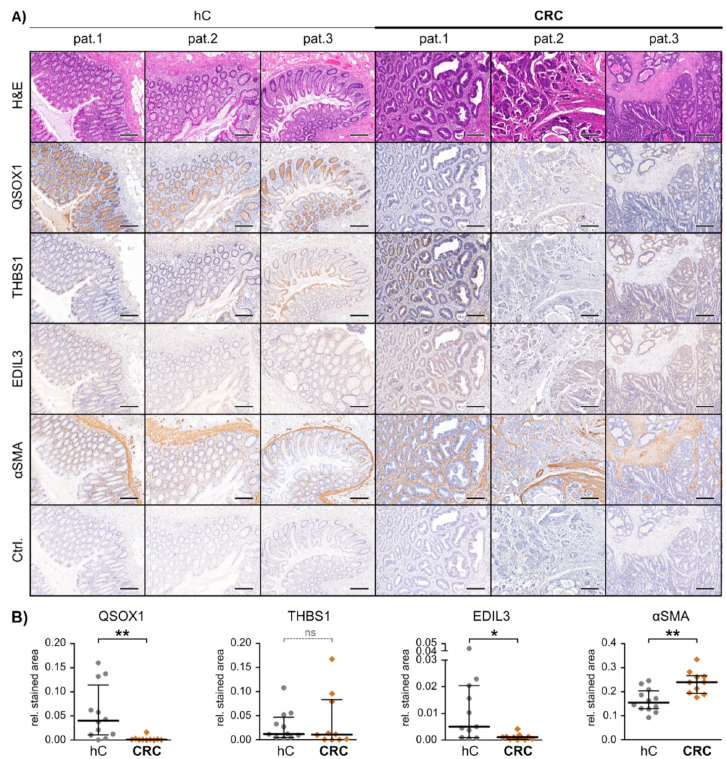
Figure 3. In vivo marker expression in patient-matched healthy and malignant colon tissue. ( A ) Rep- resentative images of paraffin embedded tissue slides of healthy (hC) and malignant (CRC) colon tissue derived from patients 1–3, hematoxylin and eosin (H&E) or immunohistochemically stained for the proteins quiescin sulfhydryl oxidase 1 (QSOX1), thrombospondin 1 (THBS1), EGF-like repeats and discoidin domains 3 (EDIL3), α -smooth-muscle actin ( α SMA) and IgG control (Ctrl.). Scale bars equal 250 µ m. ( B ) Graphical IHC staining analysis performed in QuPath. From each patient and tissue, a minimum of three representative areas were subjected to graphical and statistical